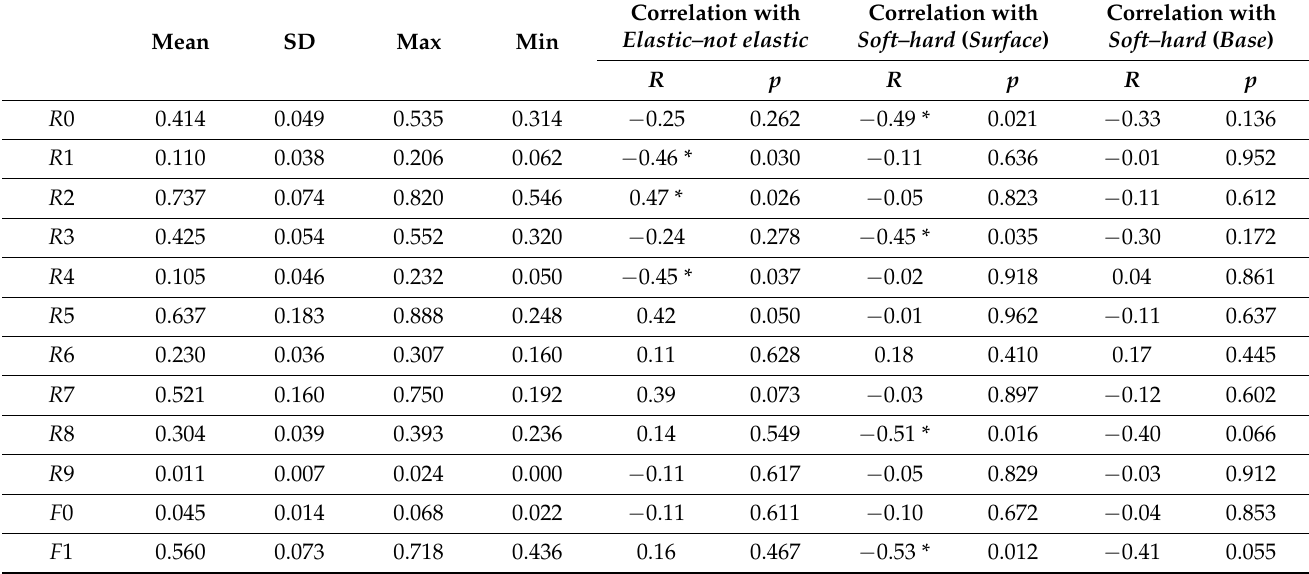
Table 6. Skin viscoelasticity parameters and correlation with sensory evaluation